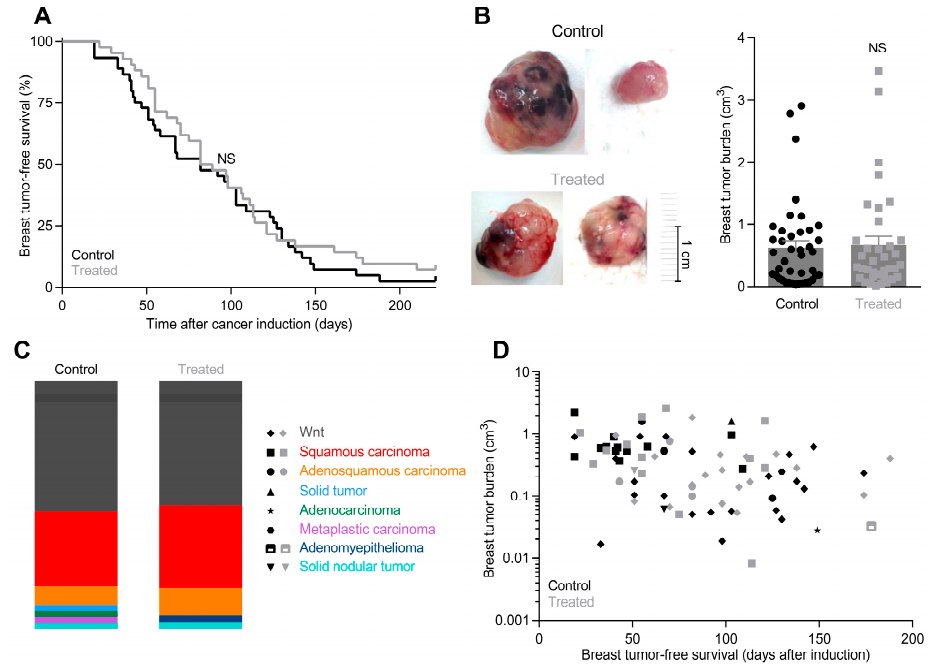
Figure 2. Tumor-free survival, tumor burden, and breast tumor histopathology are similar in NaHCO 3 -treated mice and control mice. ( A ). Tumor-free survival of NaHCO 3 -treated mice and control mice after carcinogen-based breast cancer induction. Median tumor-free survival of NaHCO 3 -treated mice was 85.5 ± 8.2 days ( n = 42) compared to 82.0 ± 7.5 days for control mice ( n = 45). Data were compared by Gehan-Breslow-Wilcoxon test. ( B ). Tumor burden was similar in NaHCO 3 -treated mice and control mice ( n = 37–41) two weeks after first tumor detection. Tumors were typically 3–4 mm at first detection consistent with previous reports [49] . Data were log-transformed in order to improve normal distribution and then compared by unpaired two-tailed Student’s t -test. ( C ). Distribution of breast tumors from NaHCO 3 -treated mice and control mice ( n = 37–41) between histopathological subtypes. ( D ). Plot of matched data for histopathology, tumor burden, and tumor latency of breast tumors from NaHCO 3 -treated mice and control mice ( n = 37–41). NS: Not significantly different vs . Control.